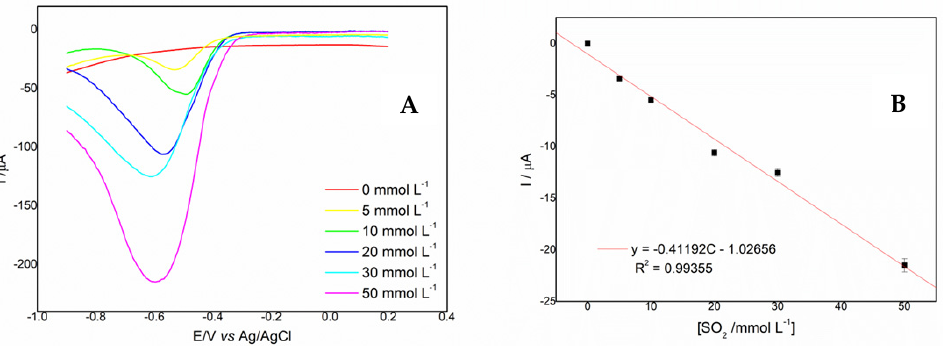
Figure 7. ( A ) Square wave voltammetry for the MWCNT/LI/AM electrode at different concentrations of sodium sulfite. ( B ) Linear regression obtained.